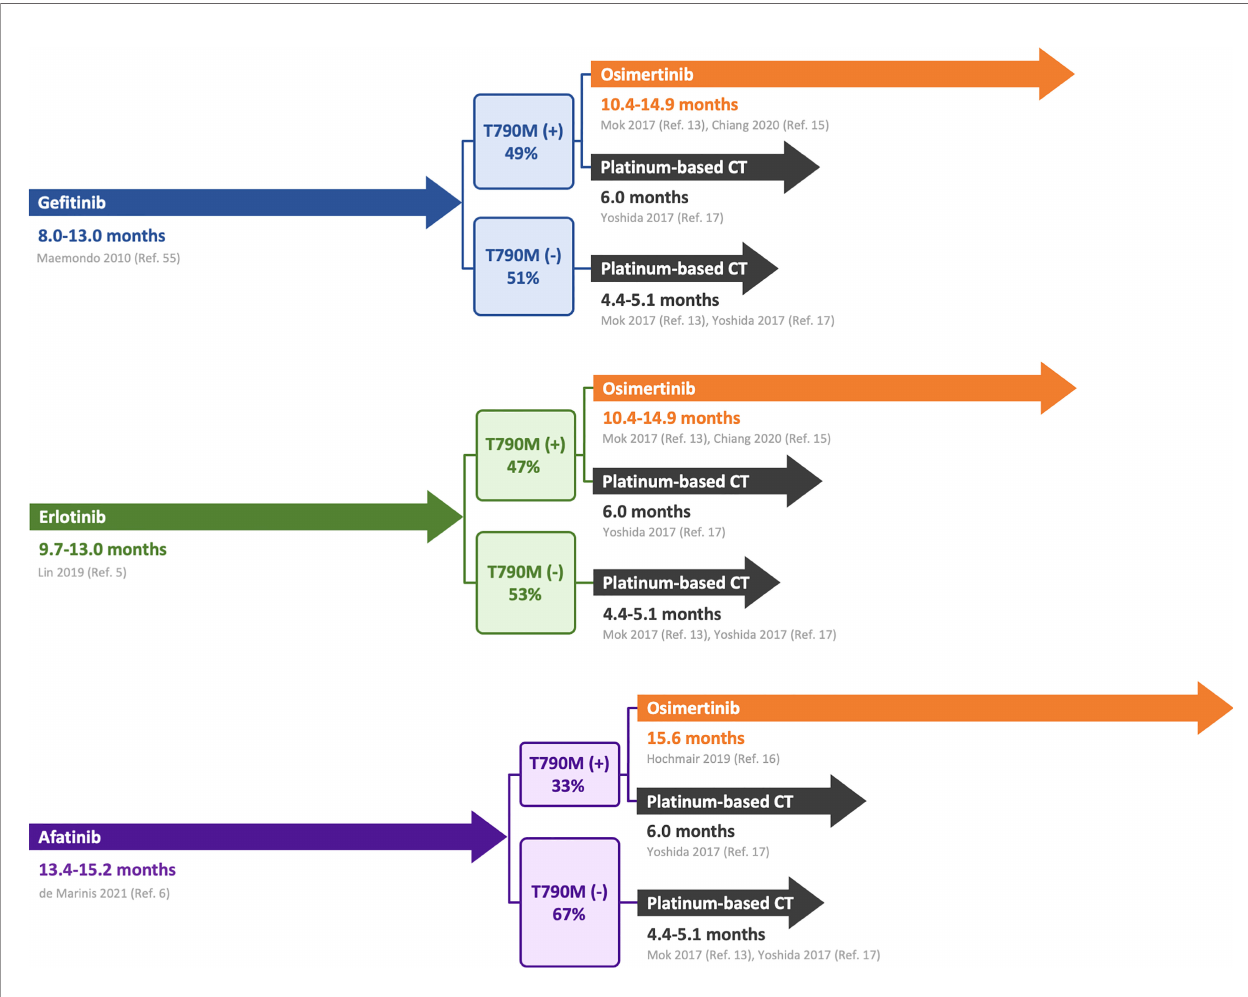
FIGURE 6 | Progression-free survival of T790M-positive and -negative